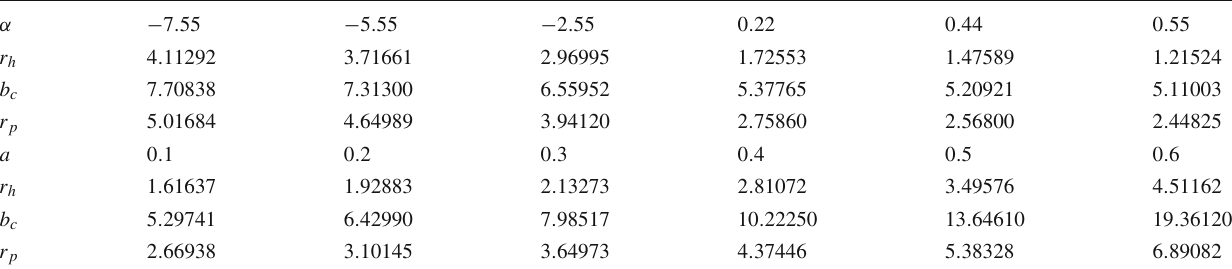
Table 1 The numerical values of involved physical quantities for various values of α and a for fixed values of Q = 0 . 1 and φ = 0 . 01 with M =